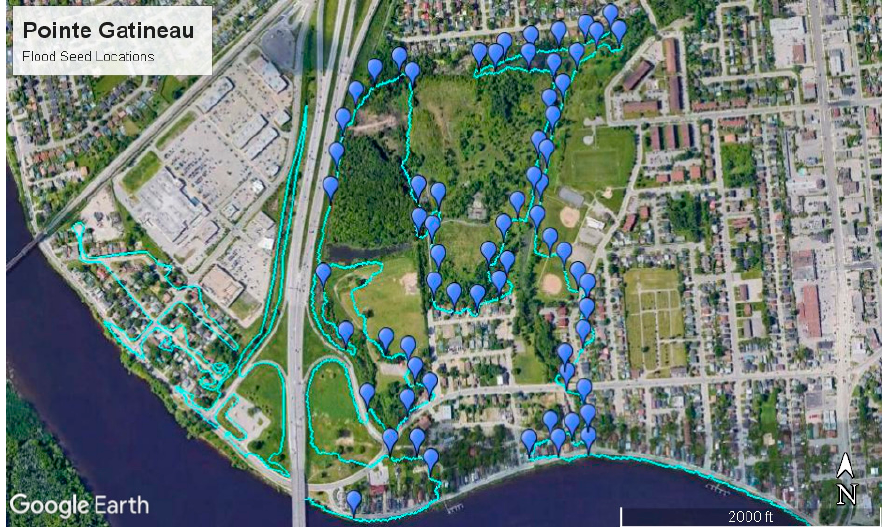
Figure 12. Location of imaginary flood perimeter observations used to flood-fill the borough of Pointe-Gatineau using the Lidar DEM.